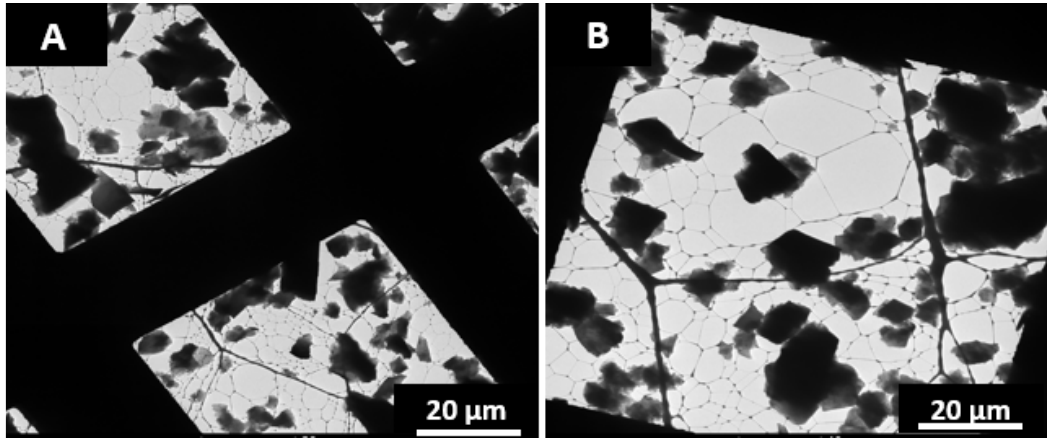
Figure A1. TEM micrographs of ( A ) Swiss-Cheese-Graphite after 30 min of ball mill and ( B ) heat-treated anthracene coke after 30 min of ball milling.